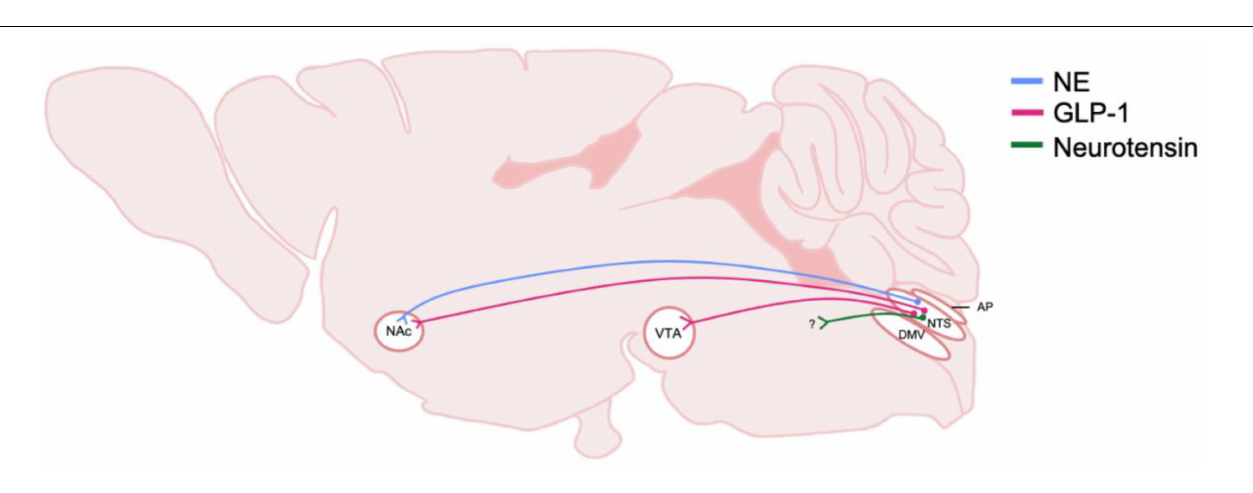
FIGURE 4 | Schematic of DVC projections hypothesized to be involved in central reward systems and AUD. The origin and distribution of central neurotransmitter and peptide pathways hypothesized to be involved in rewarding properties of alcohol. Peptide and transmitter systems include NE, norepinephrine and GLP-1, glucagon-like peptide 1 and neruotensin. These projections are derived from the NTS, nucleus of the tractus solitarius; and project to mesolimbic regions including the NAc, nucleus accumbens, and the VTA, ventral tegmental area. Question marks indicate that immunohistochemically, neurotransmitters or peptide are present, however, the termination of the projections have not been identified. DMV, dorsal motor nucleus of the vagus nerve; AP, area